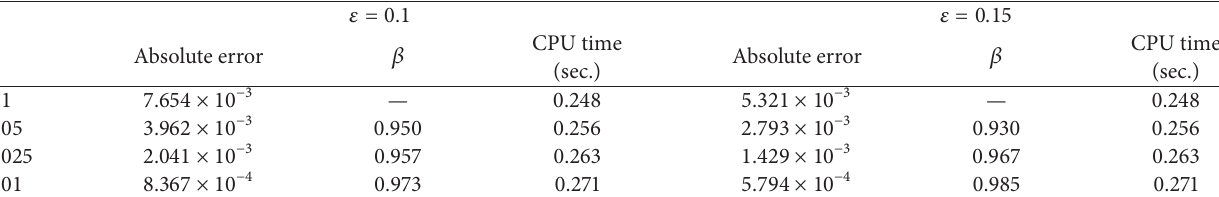
Table 2: Errors and convergence rates due to the change of 𝑘 for VG.